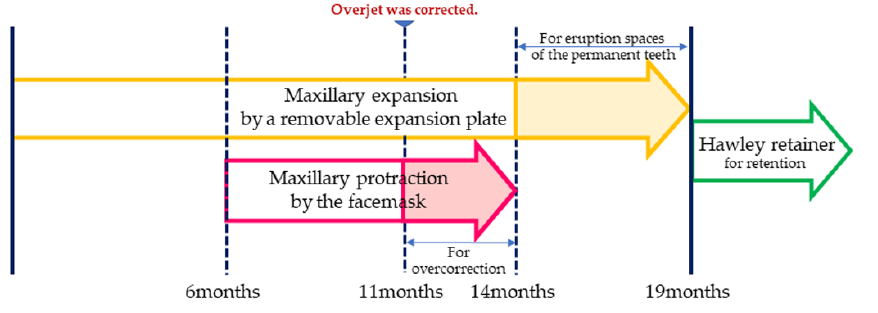
Figure 4. Time course of orthodontic treatment. At a 6-month follow-up, the overjet and overbite were well maintained (overjet, 3.5 mm and overbite, 3.0 mm). On the facial photographs, her facial profile